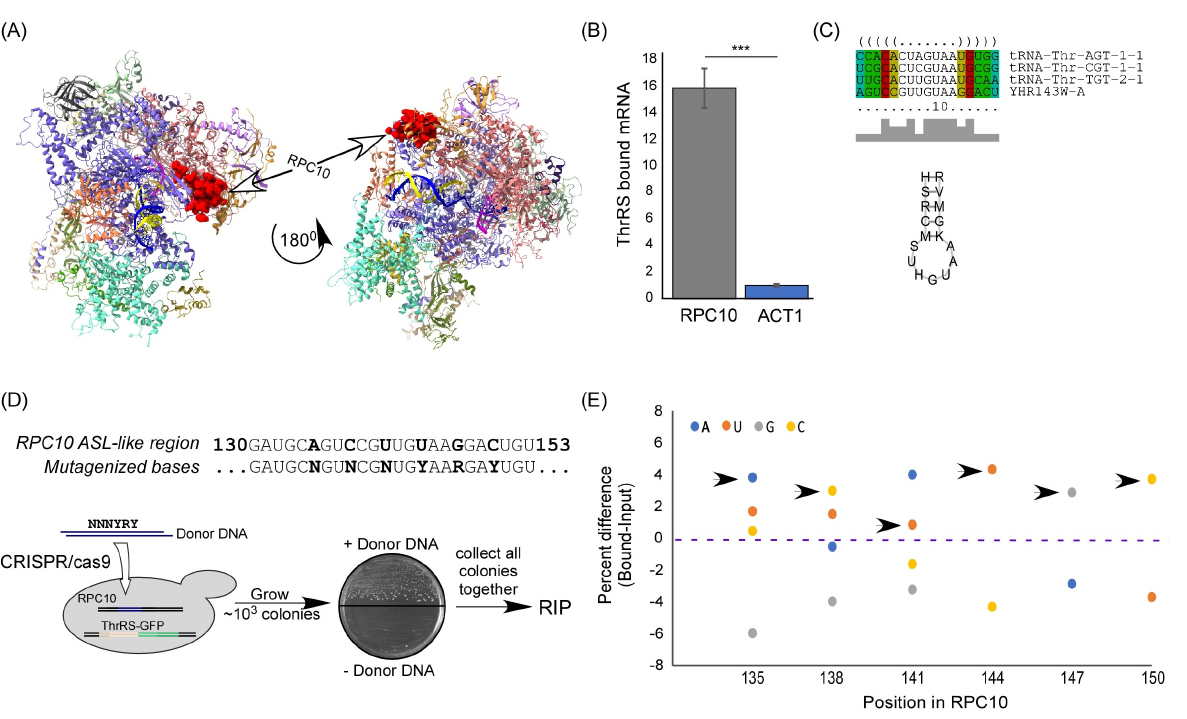
Figure 2. ThrRS binding to RPC10 mRNA is mediated by an ASL mimic. ( A ) High-resolution Cryo EM structure of RNA polymerase III (PDB 5FJ8), RPC10 is in red, DNA strands are in yellow and blue, and RNA in magenta. ( B ) ThrRS-GFP-expressing yeast strains were subjected to RIP. Amounts of bound RPC10 and ACT1 mRNAs were quantified by RT-qPCR analysis and normalized to their expression levels (Input). The histogram presents the quantification of four independent biological repeats. p -value was calculated by the dependent samples’ one-tailed t -test. *** < 0.001. ( C ) tRNA Thr and RPC10 mRNA sequence and structure alignments. Three tRNA Thr isoacceptors and RPC10 (YHR143W-A) mRNA were subjected to multiple local and structure alignments of RNA molecules using LocARNA [16]. Alignment sequences are presented at the top and consensus stem-loop structure (letters designation according to IUPAC) at the bottom. ( D ) Scheme of CRISPR/Cas9 random mutagenesis of the anticodon-like region. Donor DNA (80 bases long) with randomized bases at the indicated positions was introduced into a strain expressing ThrRS-GFP. Double strand break at the RPC10 gene was induced by CRISPR/Cas9, and colonies grew only upon homologous recombination with the Donor DNA. The resulting recombinants, which contain varying sequences at RPC10 gene, were subjected to RIP. ( E ) RNA samples from the Input and Bound RIP analysis were subjected to RT followed by PCR of the RPC10 gene (with primers RPC10 seq F and RPC10 seq R)). Products were subjected to Sanger sequencing, and the fluorescent signals of each base in each mutated position were quantified. Graph presents the relative fluorescent differences (Bound minus Input) in each position for each base. Arrows point to the bases that are present in WT RPC10